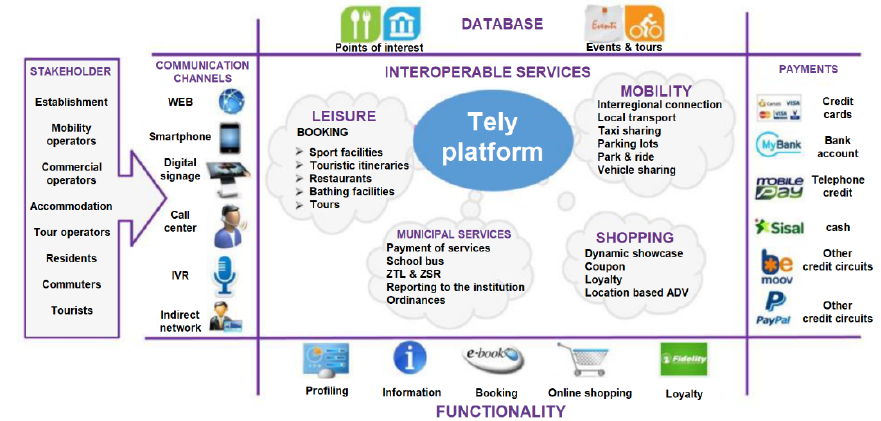
Fig. 2. Tely ecosystems. Source: elaborated from I.T.Svil